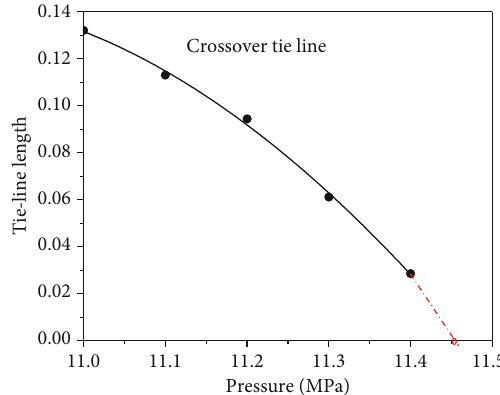
Figure 4: Extrapolation of the length crossover tie line yielded by the MMC method in this work for Case 1a (see Figure 3).